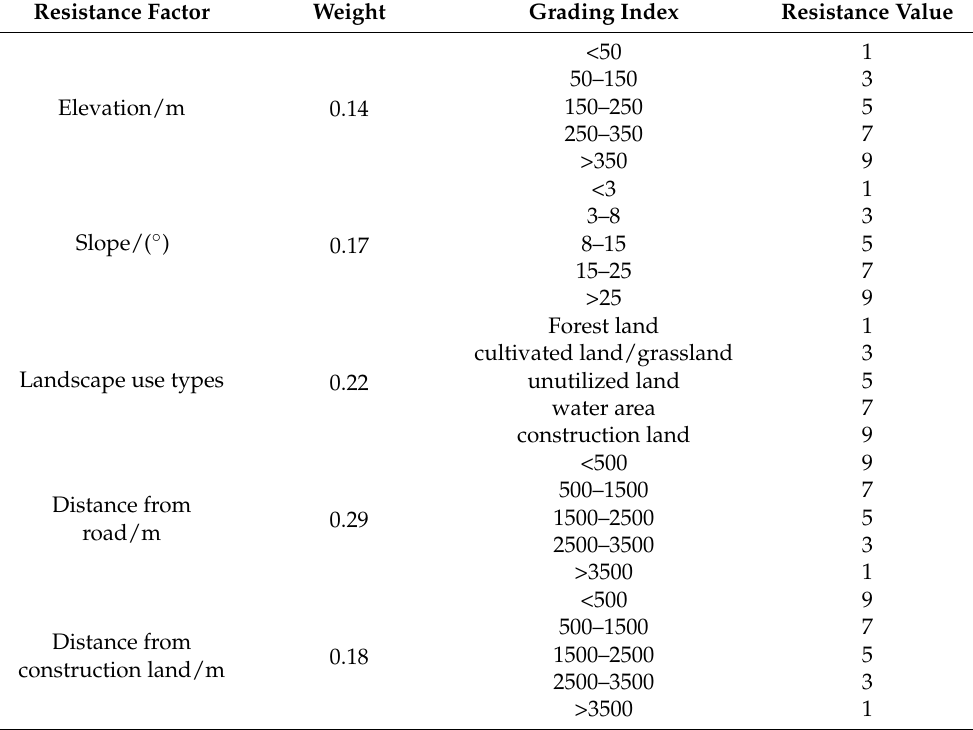
Table 2. Resistance factor classification, weight, and assignment